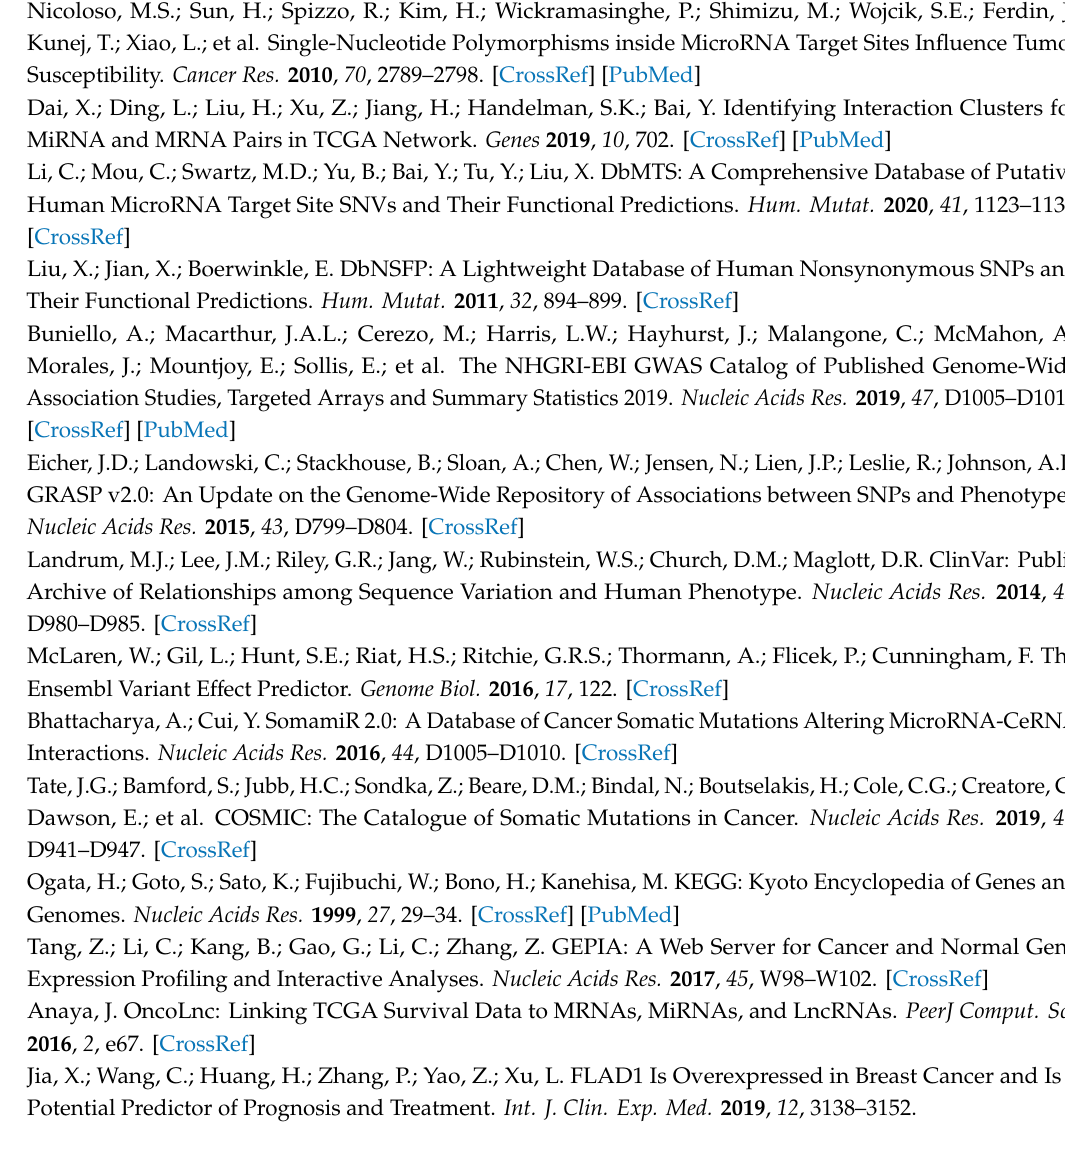
s1, Table S1: 376 SNVs identified from dbMTS; Table S2: 24 3 (cid:48) UTR SNVs identified from dbMTS; Table S3: Experimentally validated somatic SNVs located in potential miRNA target sites; Table S4: 65 candidate SNVs identified from dbNSFP; Table S5: Somatic mutations in COSMIC for nonsynonymous SNVs identified using